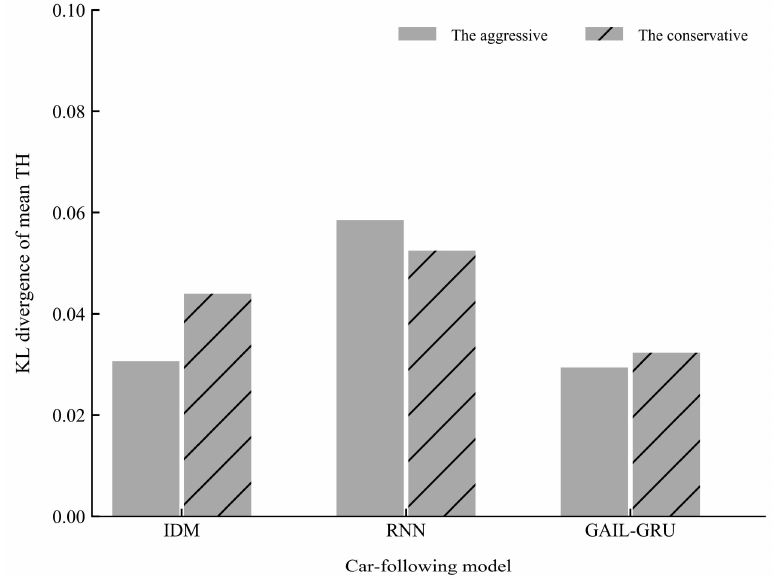
Figure 15. The Kullback-Leibler (KL) divergence of mean time headway (TH) for di ff erent models.